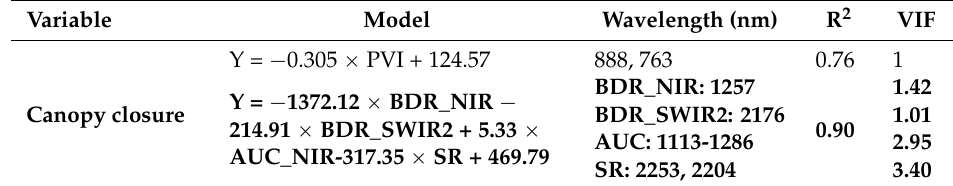
Table 3. Best performing simple and stepwise multiple regression models to estimate canopy closure.